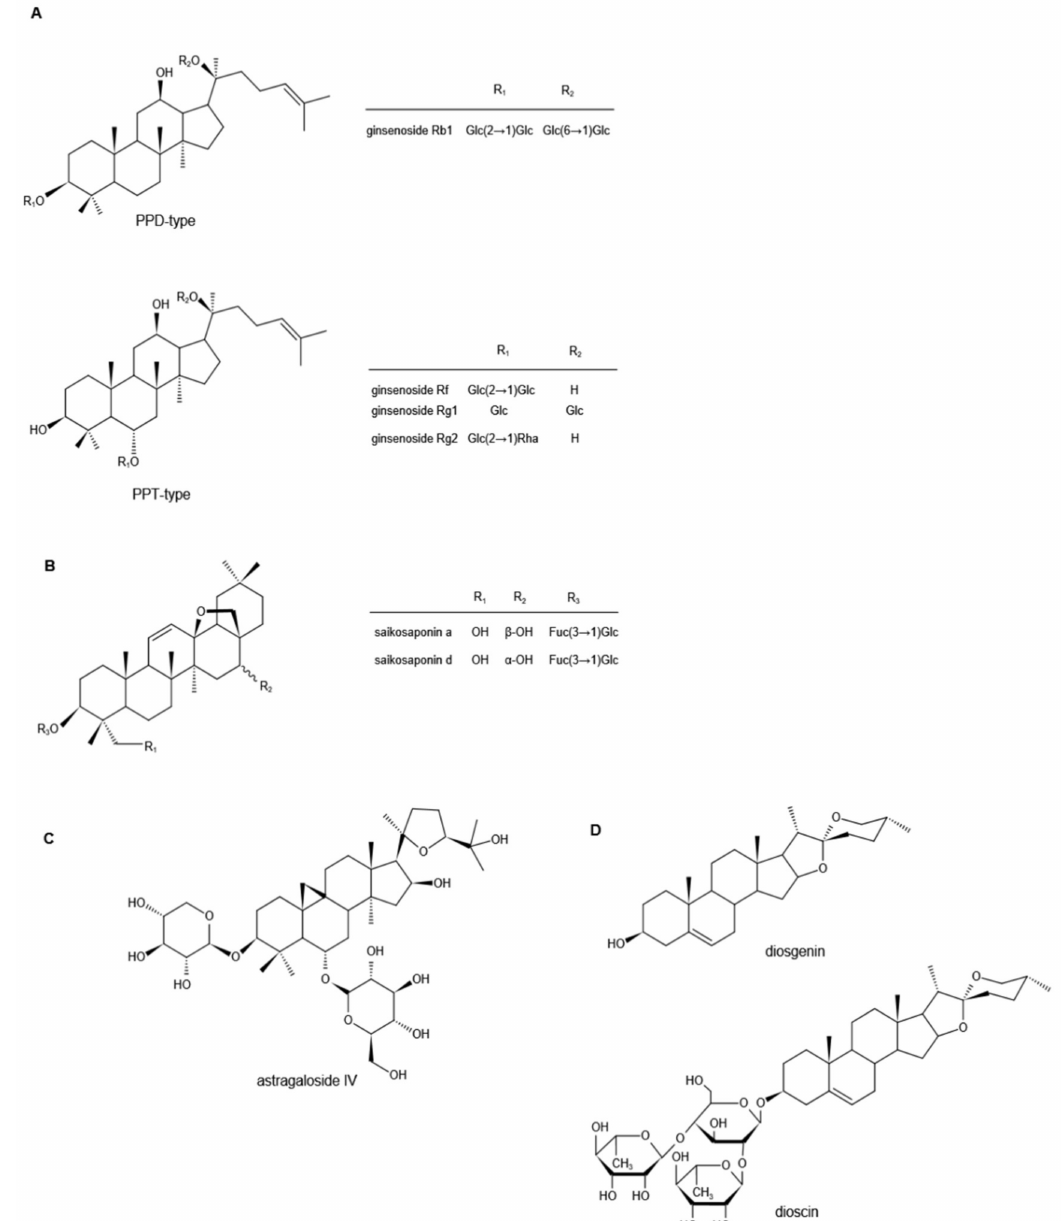
Figure 2. Chemical structures of ginsenosides ( A ), saikosaponins ( B ), astragaloside IV ( C ), and diosgenin and dioscin ( D ) (Note: PPD, protopanaxadiol; PPT, protopanaxatriol; Glc, glucoside; Rha, rhamnoside; Fuc,